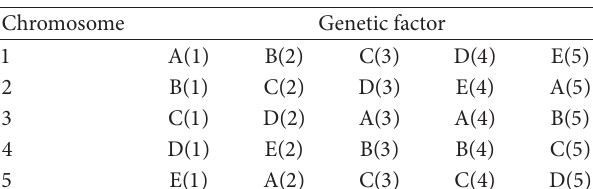
Table 3: Chromosomes after